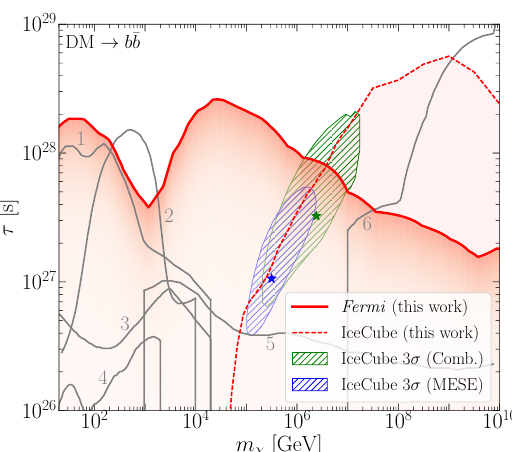
Figure 11: Lower bounds on the decay lifetime for DM decaying to b quarks. The red line is determined by Ref. [ 56 ] using Fermi data; gray lines with num- bers denote existing bounds using data from Fermi (2,3,5), AMS-02 (1,4), and PAO / KASCADE / CASAMIA (6). The hashed green (blue) region suggests parame- ter space where DM decay may provide a ∼ 3 σ improvement to the description of the combined maximum likelihood IceCube neutrino flux. The red dotted line pro- vides a limit if a combination of DM decay and astrophysical sources are responsible for the observed high-energy neutrinos. Reproduced from Ref. [ 56 ] .